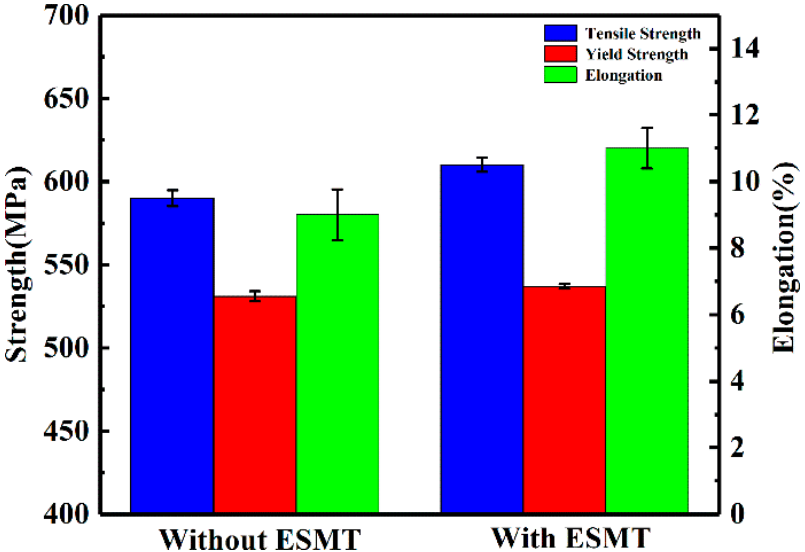
Figure 8. Mechanical properties of squeeze castings under different conditions.